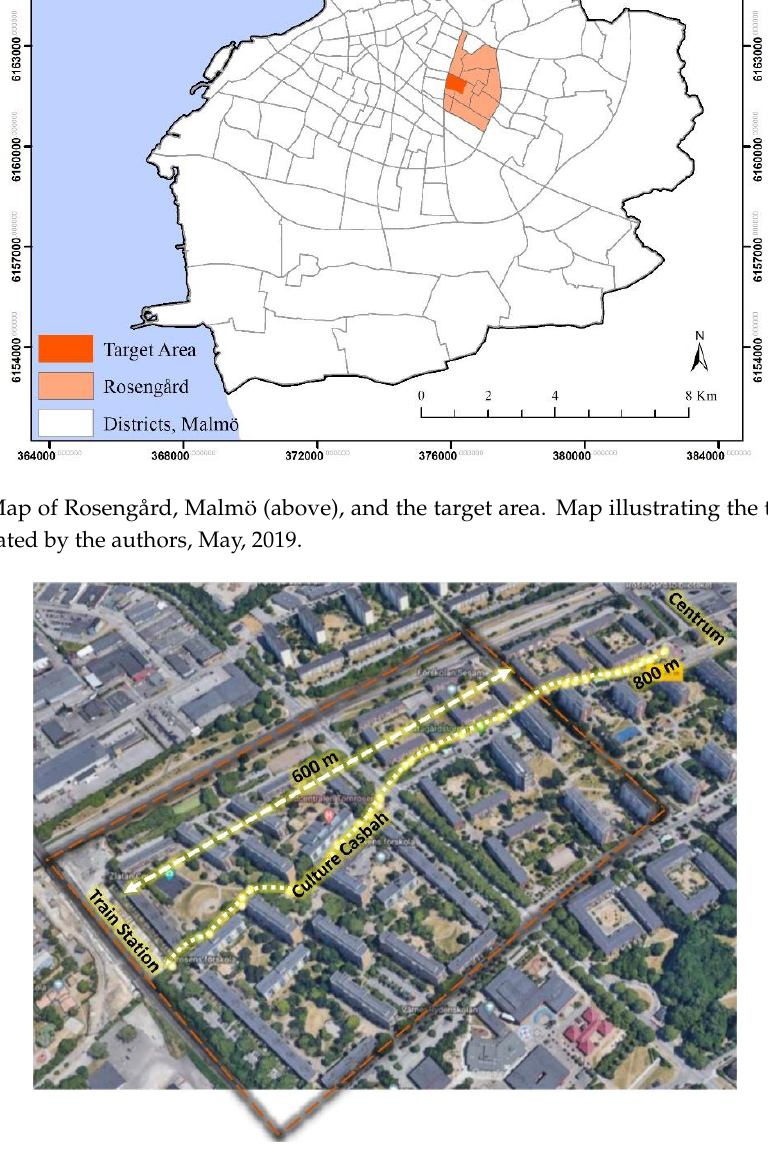
Figure 4. The treated area inbound the red border (including 1660 apartments) located between the station and the Centrum. source: Created by the authors, May, 2019.